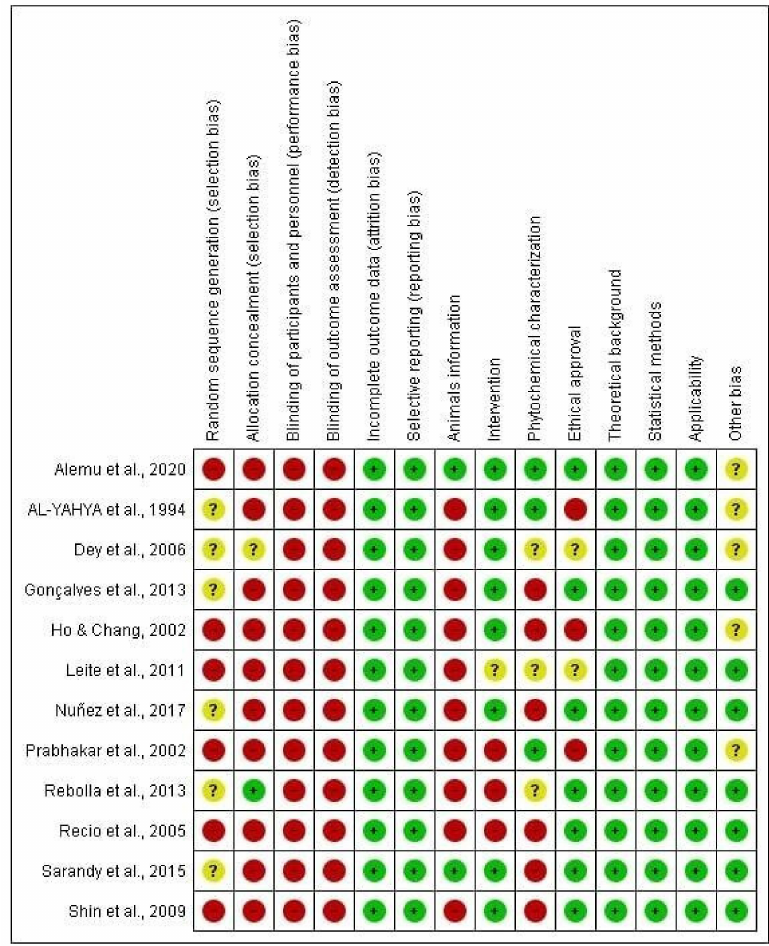
Figure 4. Risk of bias summary: review authors’ judgments about the risk of bias items for each included study. Green: low risk of bias; yellow: unclear risk of bias; and red: high risk of bias. References of the articles in the figure: